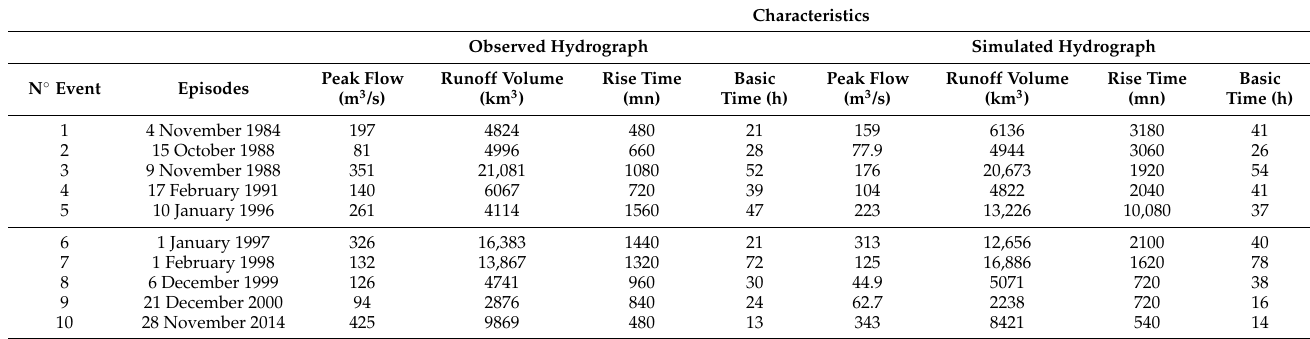
Table 7. Characteristics extracted by hydrographs after model calibration and validation.